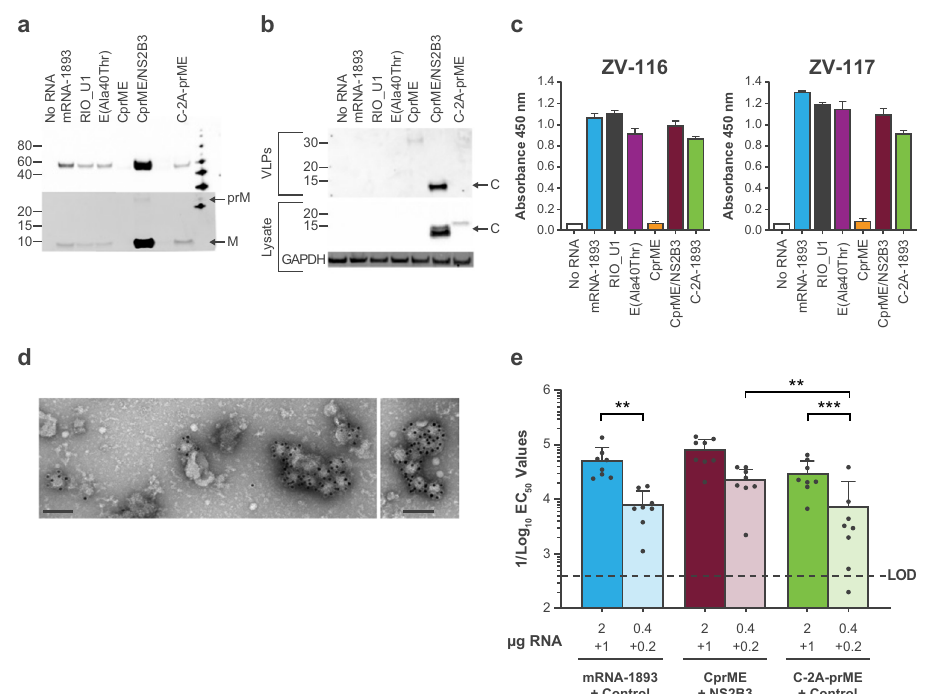
Fig. 6 ZIKV CprME mRNA VLP generation in vitro and immunogenicity in mice. a The VLP pellet was blotted for E protein using ZV-116 (top) and prM and M proteins were blotted using an anti-Zika prM polyclonal antibody (bottom). Arrows indicate prM and M. Molecular weights were estimated using a mixture of MagicMark XP Western Protein Standard (Invitrogen) and Precision Plus Dual Color Standards (Bio- Rad, cat. no. 1610374) to obtain reference bands every 5 to 10 kDa. b Puri fi ed VLPs (top) and lysates from transfected cells (bottom) were blotted for C protein using an anti-Zika capsid polyclonal antibody. ( c ) VLP secretion was measured by sandwich ELISA, with either ZV-116 (left) or ZV-117 (right), followed by the addition of the anti-E antibody ZV-67 and an anti-mouse HRP-conjugated secondary antibody. Data are representative of a single experiment, with error bars indicating the SD of technical repeats on the same plate (ie, triplicate wells). d Cells were transfected with CprME + NS2B3 mRNAs. Concentrated VLPs were stained with uranyl acetate and labeled with ZV-116 at 30,000× magni fi cation, followed by a gold-labeled anti-human secondary antibody. Scale bar indicates 100 nm. e nAb titers were measured using the ZIKV RVP neutralization assay on day 56 following 2 doses of mRNA administered on day 1 and day 29. Colored bars represent GMT for each group (mean ± SD), and black circles represent individual animals ( n = 8 per group). Dashed line indicates assay LOD. Statistical analysis was performed using two-way ANOVA. * P < 0.05, ** P < 0.005, *** P < 0.001. ANOVA, analysis of variance; C, capsid; CprME, capsid, premembrane/ membrane, and envelope; E, envelope; EC 50 , half-maximal effective concentration; ELISA, enzyme-linked immunosorbent assay; GMT, geometric mean titer; HRP, horseradish peroxidase; LOD, limit of detection; M, membrane; nAb, neutralizing antibody; prM, premembrane/ membrane; prME, premembrane/membrane and envelope; RVP, reporter virus particle; SD, standard deviation; VLP, virus-like particle; ZIKV, Zika